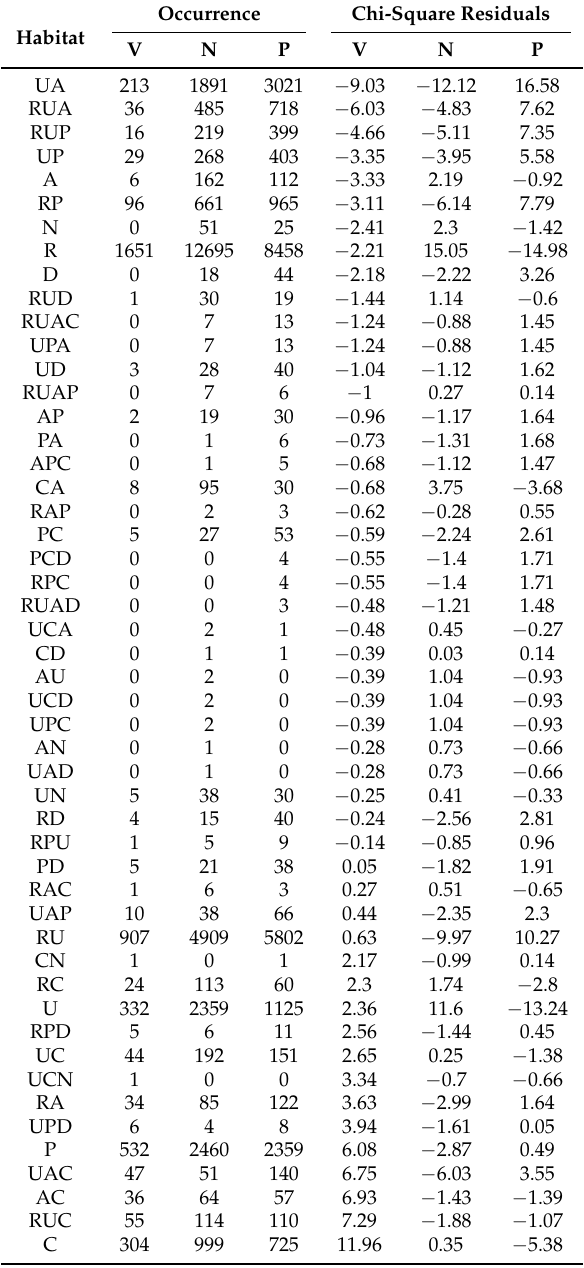
Table 6. Habitat preference and avoidance by prey (V), non-aggressive adults (N), and aggressive predators (P). Occurrence: total number of individuals observed in each indicated habitat. Chi-square residuals: the Pearson residuals (observed minus expected)/sqrt(expected). All rows of this table are sorted by the chi-square residuals of the